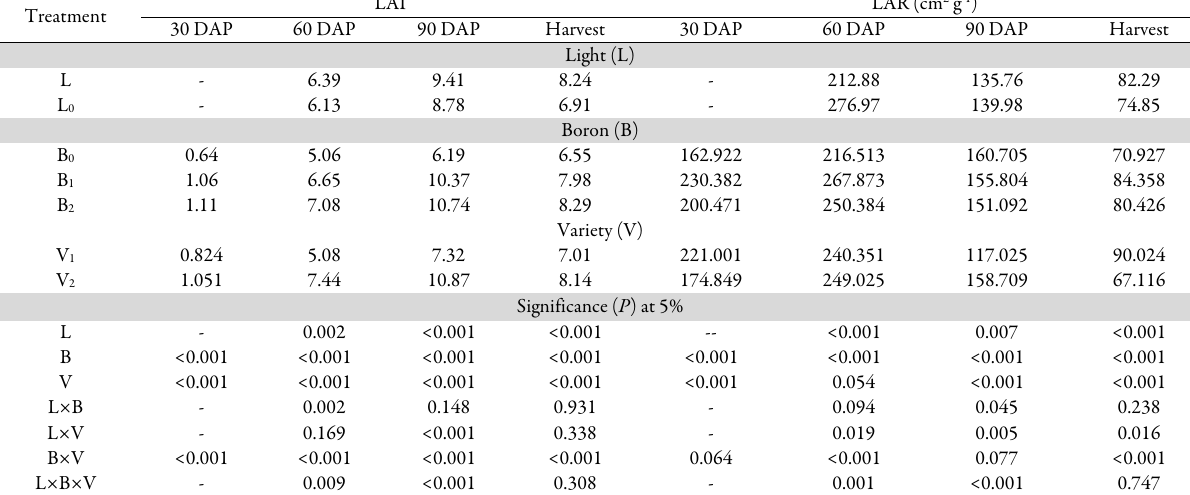
Table 3. Effect of light and boron on leaf area index and leaf area ratio of two groundnut varieties (mean of two trails)